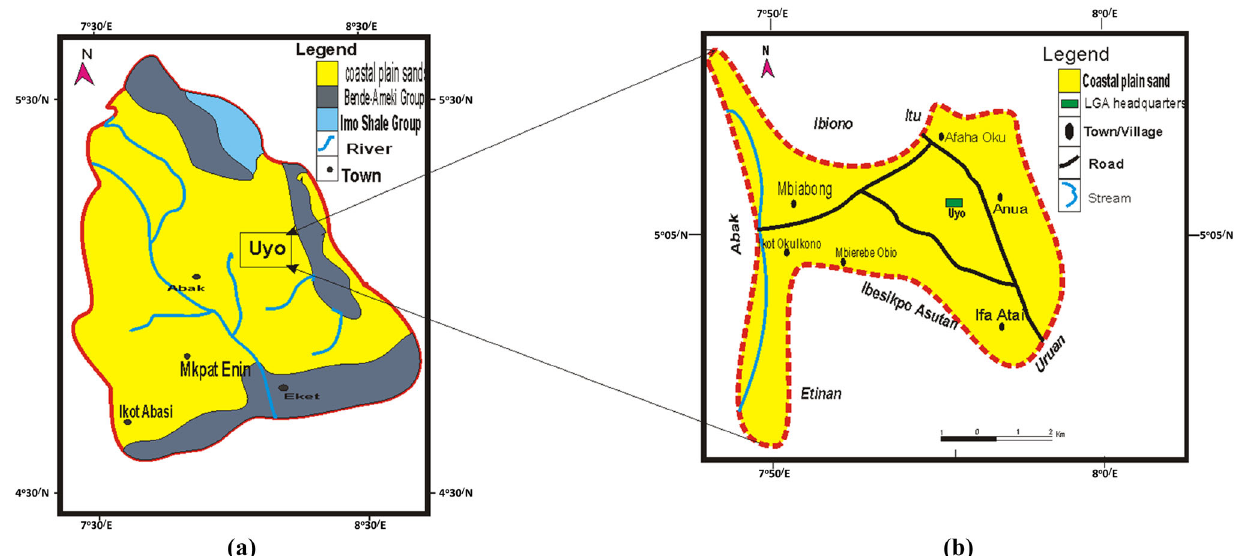
Fig. 1 a Sketch geologic map of Akwa Ibom State showing the location of Uyo Local Government Area. b Map of Uyo Local Government